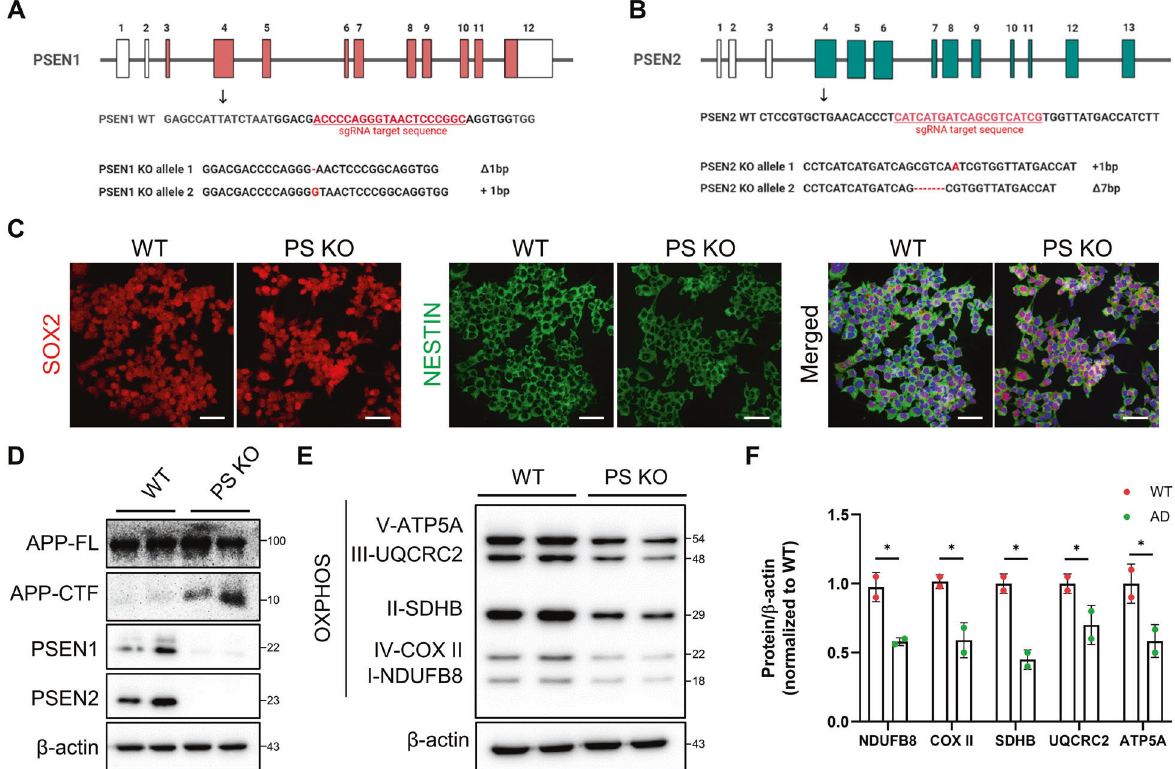
Fig. 4 Deletion of PSEN in iNSCs and altered mitochondrial function in PSEN KO-iNSCs. A Schematic diagram showing the sgRNA target site for the generation of human PSEN1 knockout iNSCs by the CRISPR/Cas9 system. B Schematic diagram showing the sgRNA target site for the generation of human PSEN2 knockout iNSCs by the CRISPR/Cas9 system. C Representative images showing SOX2 and NESTIN in WT- and PSEN KO-iNSCs. Scale bars, 50 µm. D The levels of PSEN1, PSEN2, and APP-CTFs in iNSCs after PSEN deletion. E Western blotting of OXPHOS in vehicle- or γ -secretase inhibitor-treated WT- and PSEN KO-iNSCs using OXPHOS cocktail antibodies. F Quanti fi cation of the levels of NDUFB8, COX-II, SDHB, UQCRC2, and ATP5A in WT and PSEN KO-iNSCs. Statistical analysis was performed by Student ’ s t -test. * P < 0.05. The results are presented as the means ±